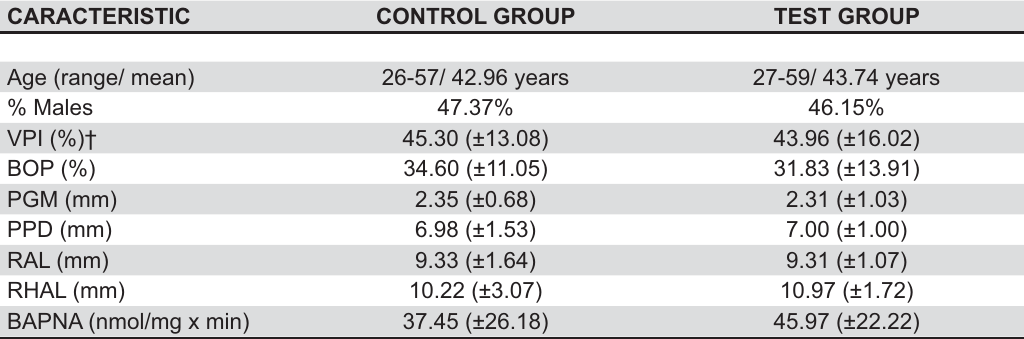
Table 1- Baseline means (± standard deviation) of age, gender, clinical and biochemical parameters*